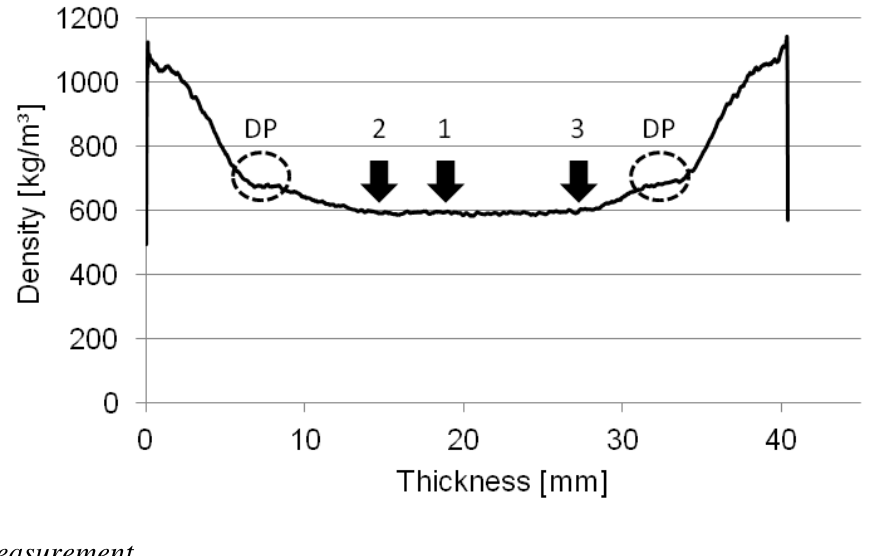
Figure 3. Representative density profile and density plateau (DP) of internal bond specimens with a thickness of 38 mm; corresponding failure zones of Specimens 1–3, which were analyzed by means of